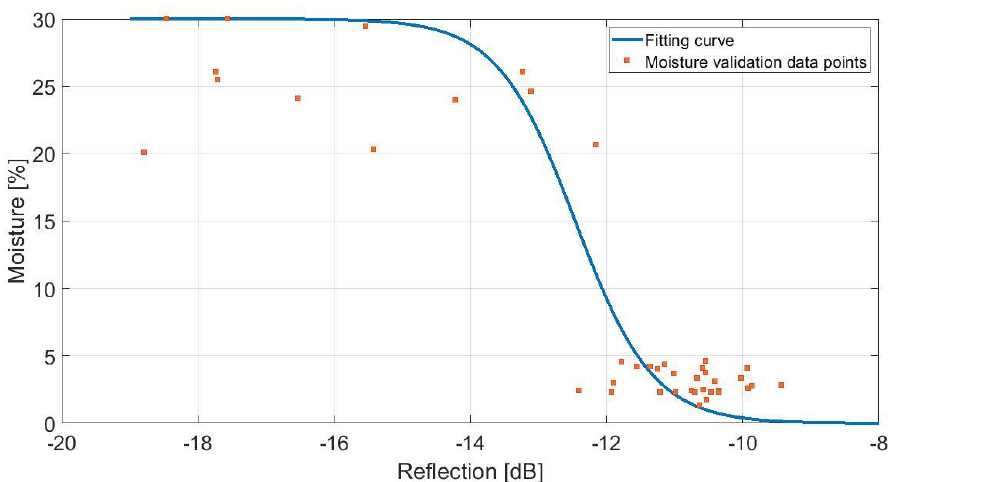
Figure 8. In situ moisture data points used for validating. The moisture fitting curve (i.e., the predicted moisture curve obtained by using Equation (6) with the coefficients reported in Table